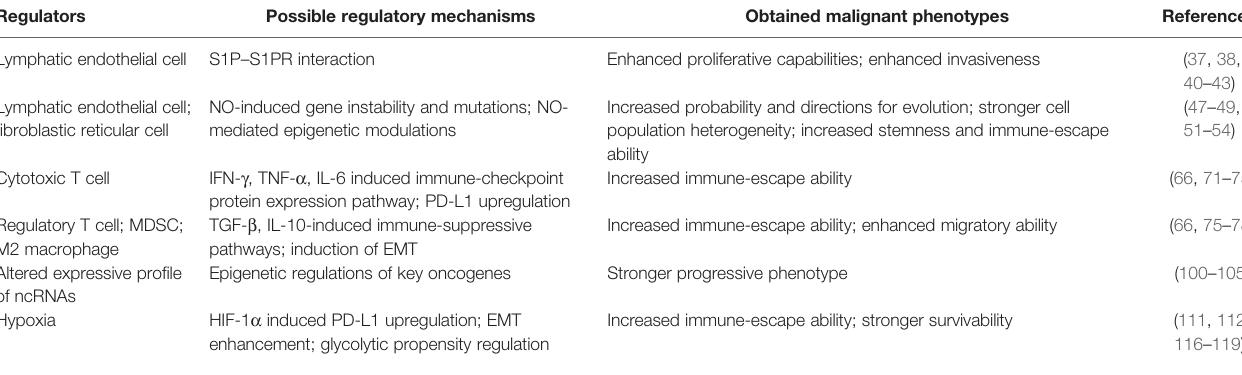
TABLE 1 | Possible regulatory roles played by different components from the lymph node microenvironment for metastatic tumor reprogramming.